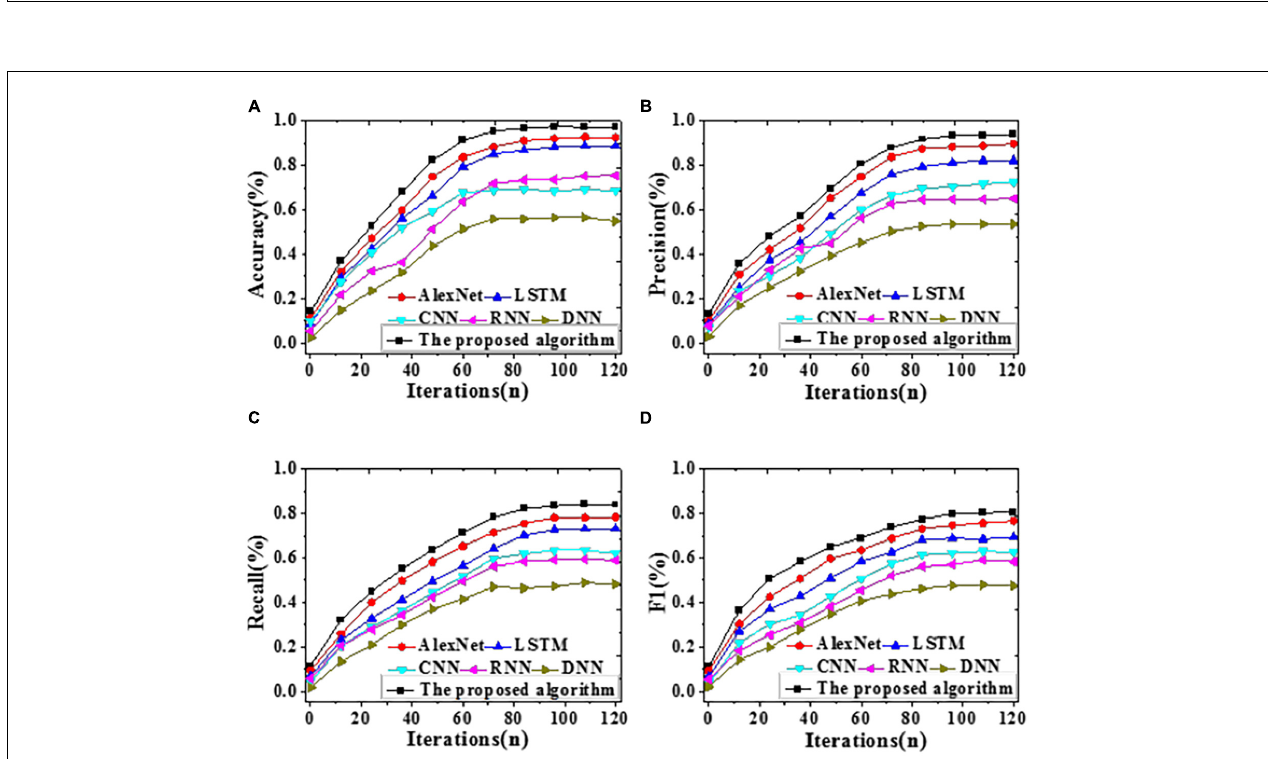
FIGURE 7 | The recognition accuracy of different algorithms with iteration on the test dataset [ (A) Accuracy; (B) Precision; (C) Recall; (D) F1 score].